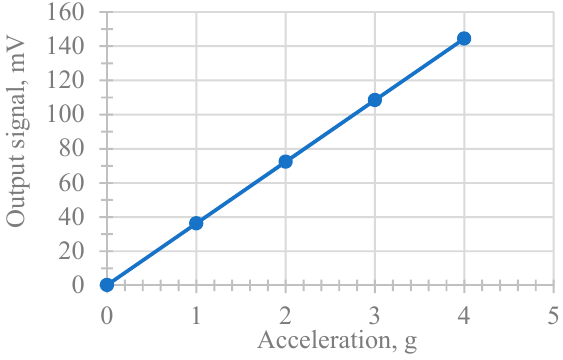
Figure 4. Proposed sensor sensitivity (modeling results).